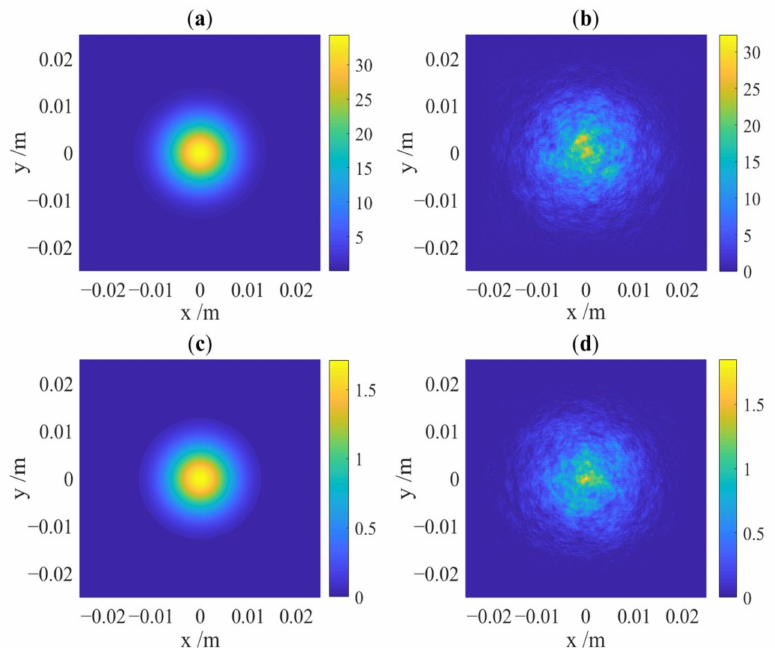
Figure 5. Intensity distributions of the received spots in ( a ) the vacuum, ( b ) the water with turbulence only, ( c ) the water with attenuation only, and ( d ) the water with attenuation and turbulence simultaneously.